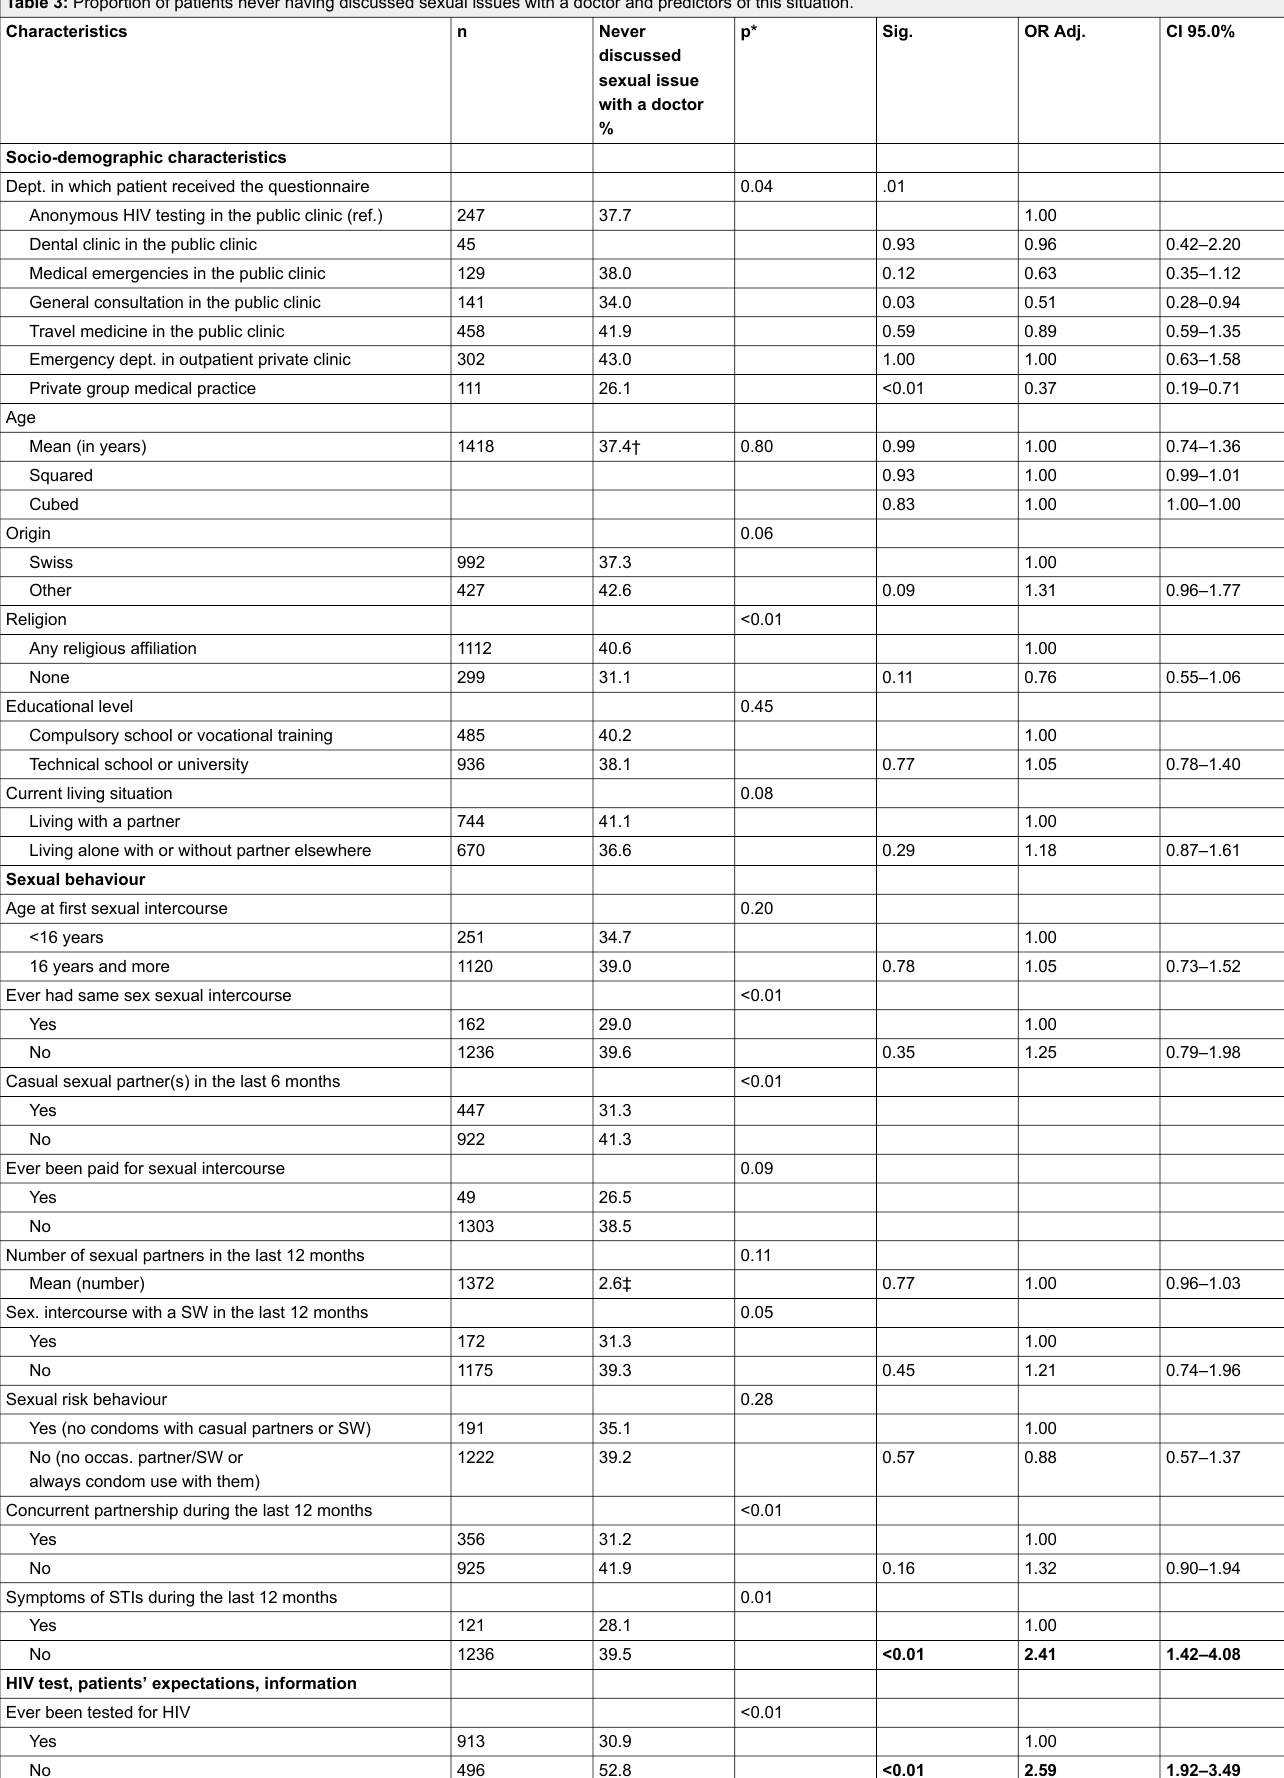
Table 3: Proportion of patients never having discussed sexual issues with a doctor and predictors of this situation. Characteristics n Never